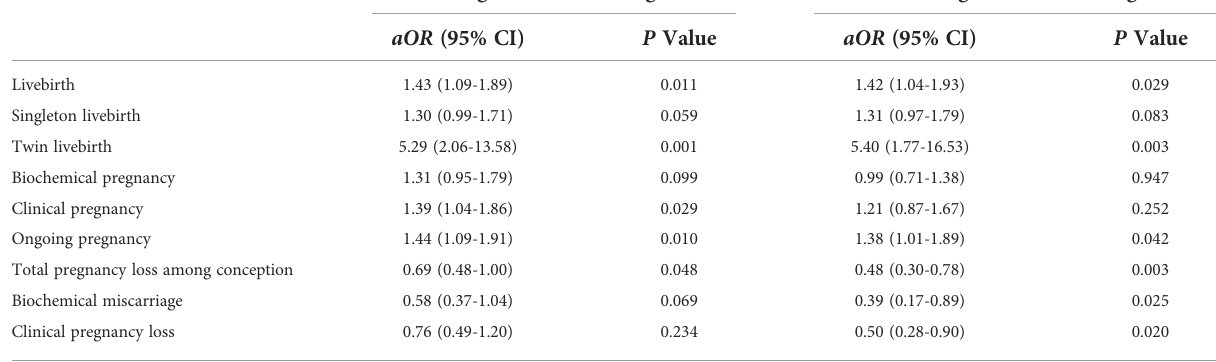
TABLE 4 Logistic regression of pregnancy outcomes.